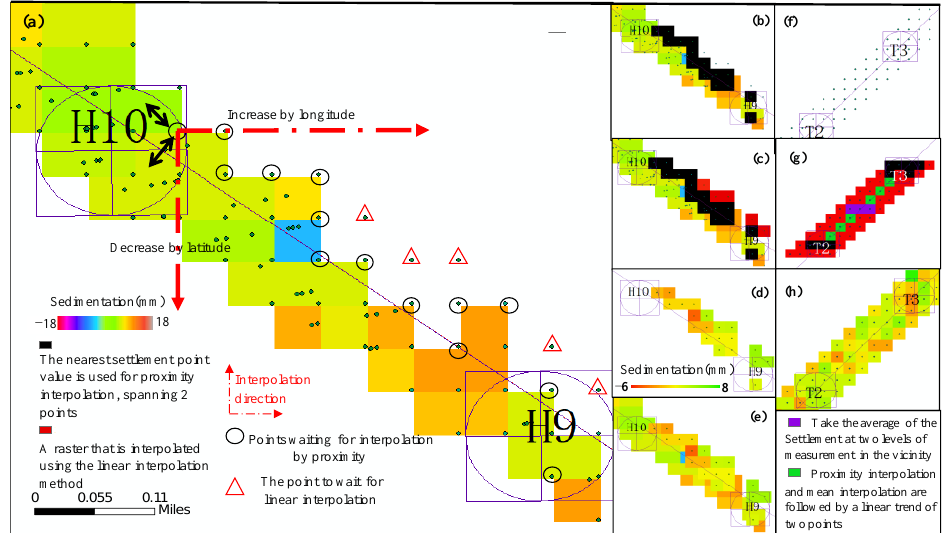
Figure 20. ( a ) the deformation of H9-H10 section of Seawall Road pavement, ( b – e ) the first type of adjacent edge missing, interpolation process and results using the adjacent method, ( f – h ) the type of completely missing road deformation data of the second type and its processing method.